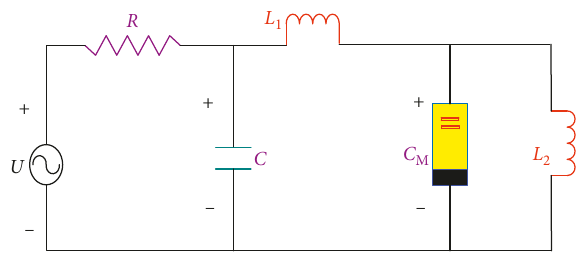
Figure 1: Four-order passive circuit based on voltage-controlled voltage comes to zero.